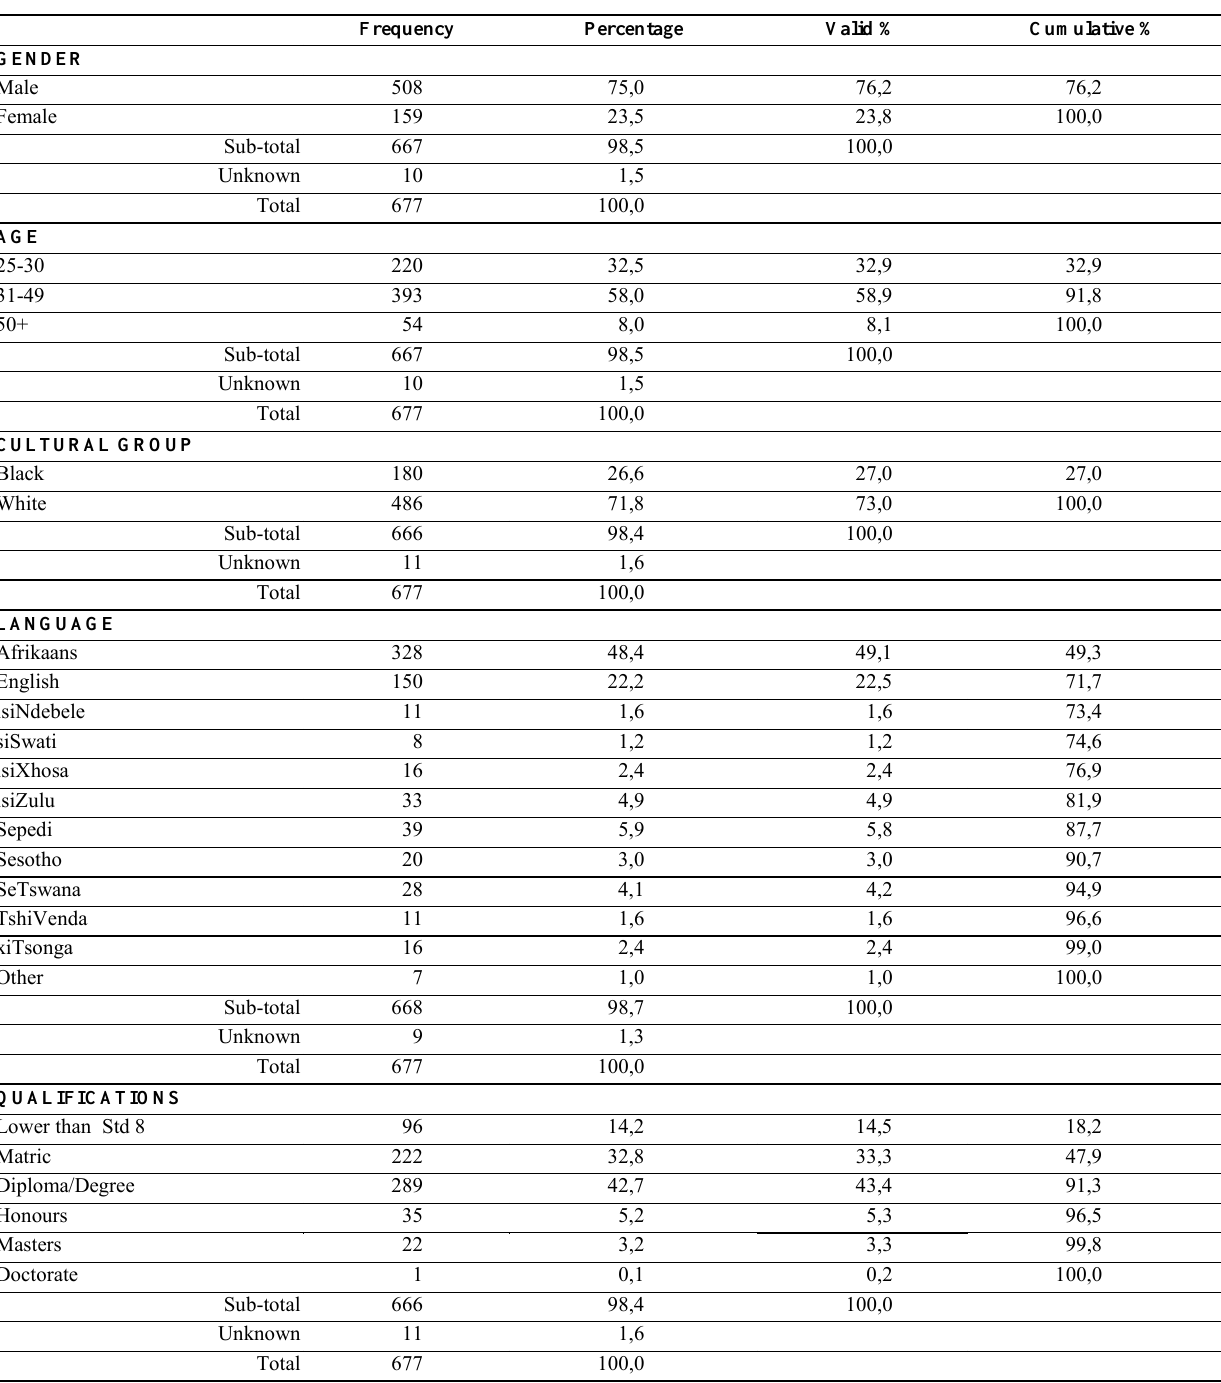
Table 1 : Biographical information of the respondents